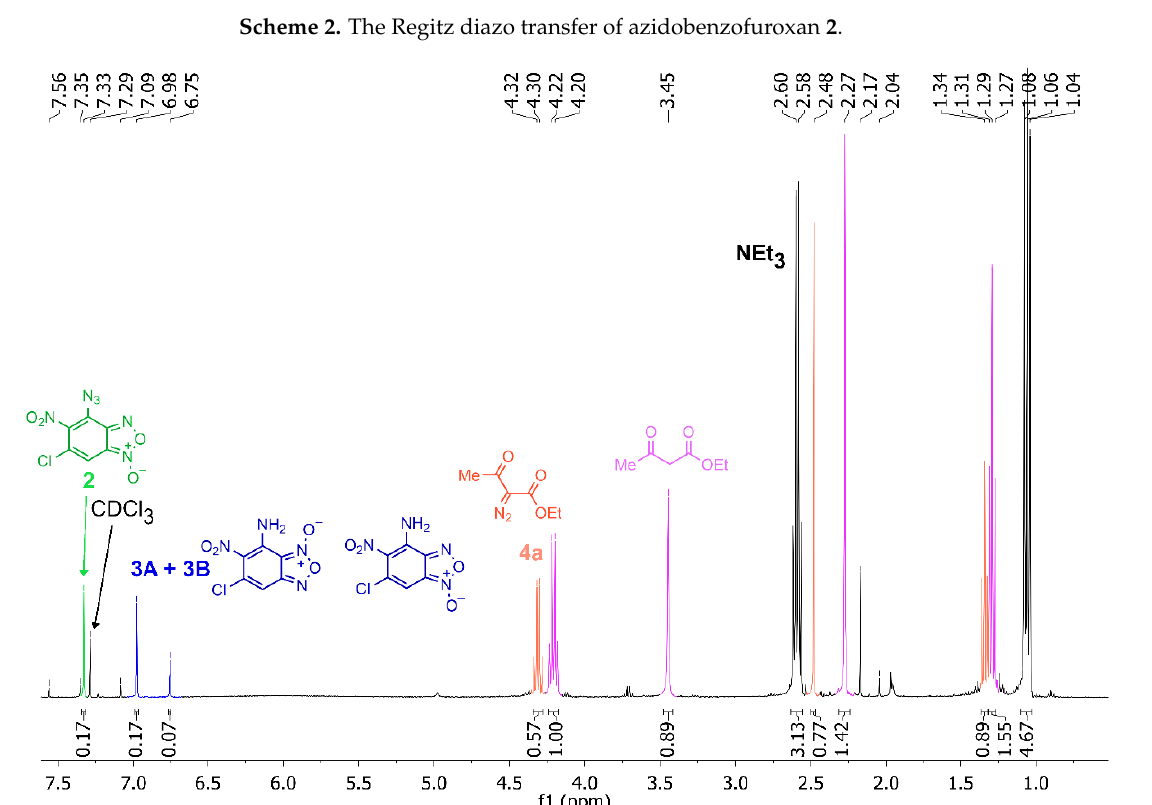
Figure 1. The 1 H NMR spectra of the reaction mixture of the azidonitrobenzofuroxan 2 with ethylacetoacetate (CDCl 3 , 400 MHz, 303 K).